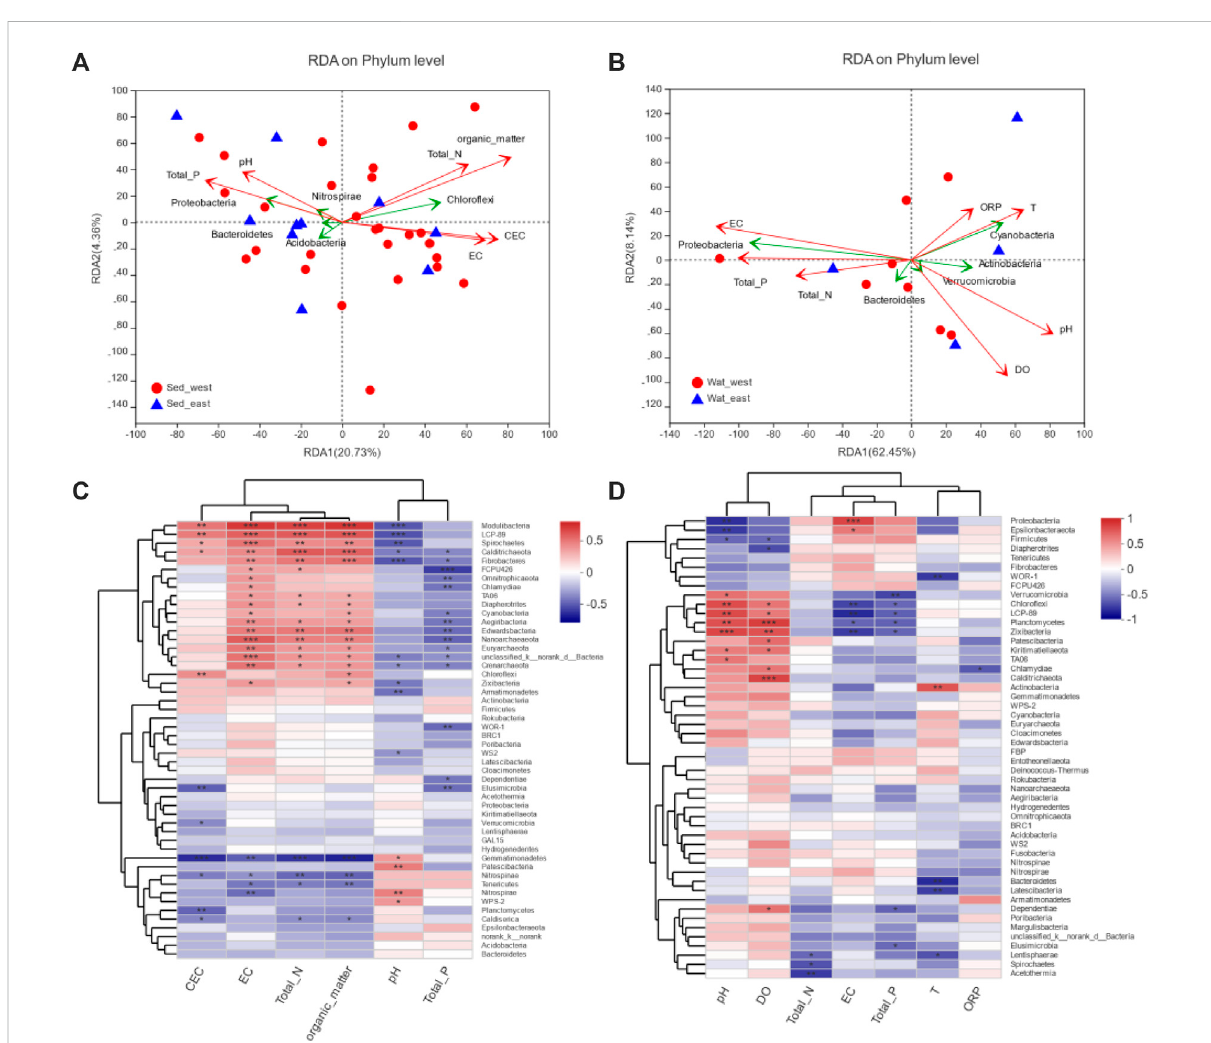
FIGURE 6 Correlation analysis of environmental variables with microbial communities: (A) RDA analysis for sediment samples, (B) RDA analysis for water samples, (C) Spearman correlation heatmap for sediment samples, (D) Spearman correlation heatmap for water